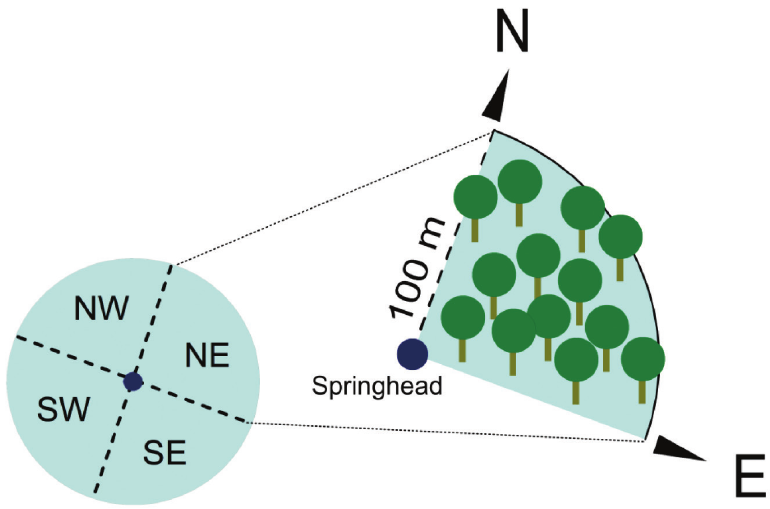
Figure 2. Four-segment approach of adjacent biotope types mapping for